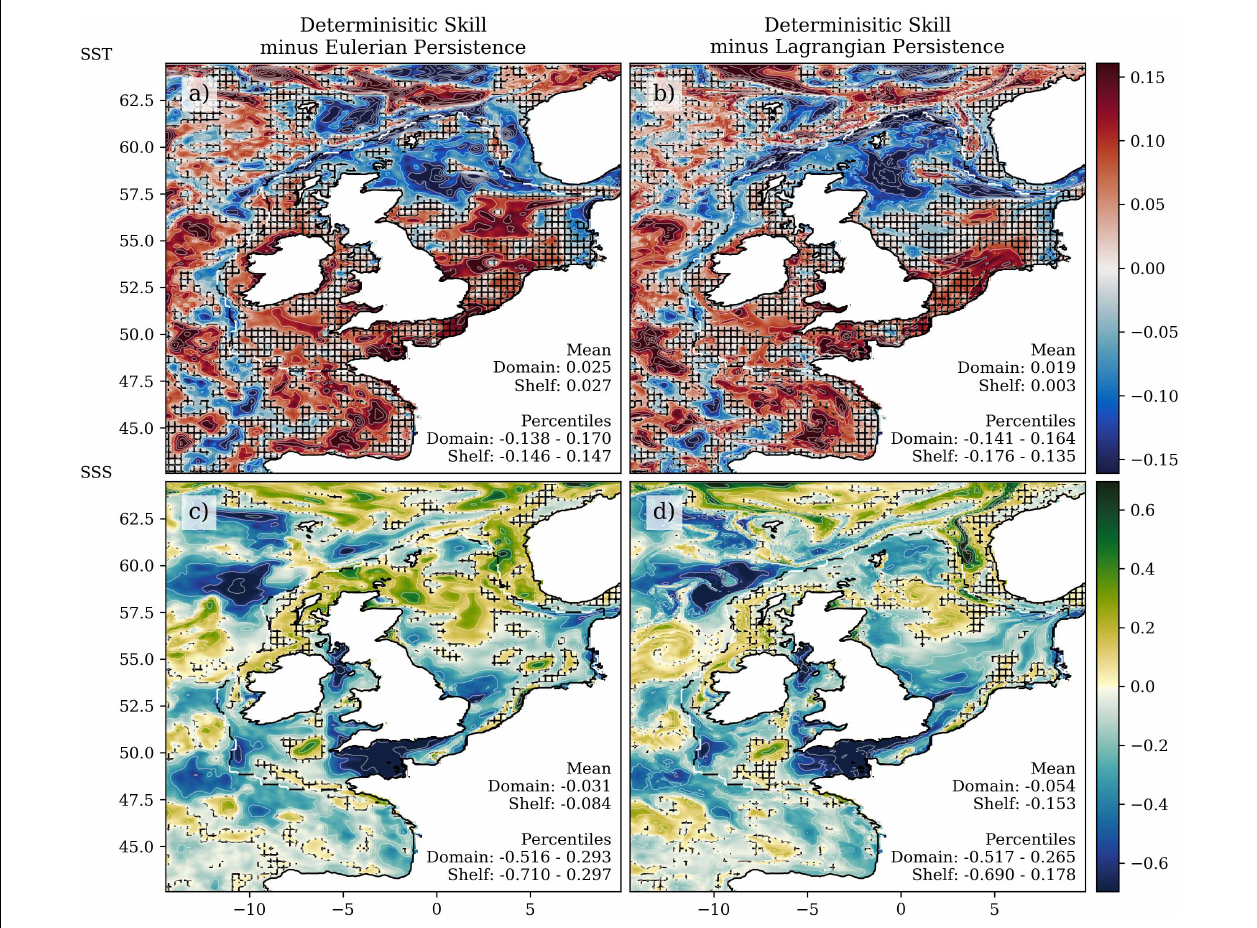
FIGURE 7 | Deterministic skill minus (Eulerian and Lagrangian) persistence for SST (a,b) and SSS (c,d) (Eulerian a,c , and Lagrangian b,d ). Insignificant differences are marked with hatching. The proportion of the NWS where the skill is significantly greater or less than persistence is tabulated in Table 1 . Spatial statistics, including the mean value, and the range of values at the 5th and 95th percentiles, are given in each panel. TABLE 1 | Proportion of the NWS where the deterministic skill is significantly greater or less than persistence, and where there is no significant difference, for Eulerian and Lagrangian persistence, for SST and SSS. Eulerian persistence Lagrangian